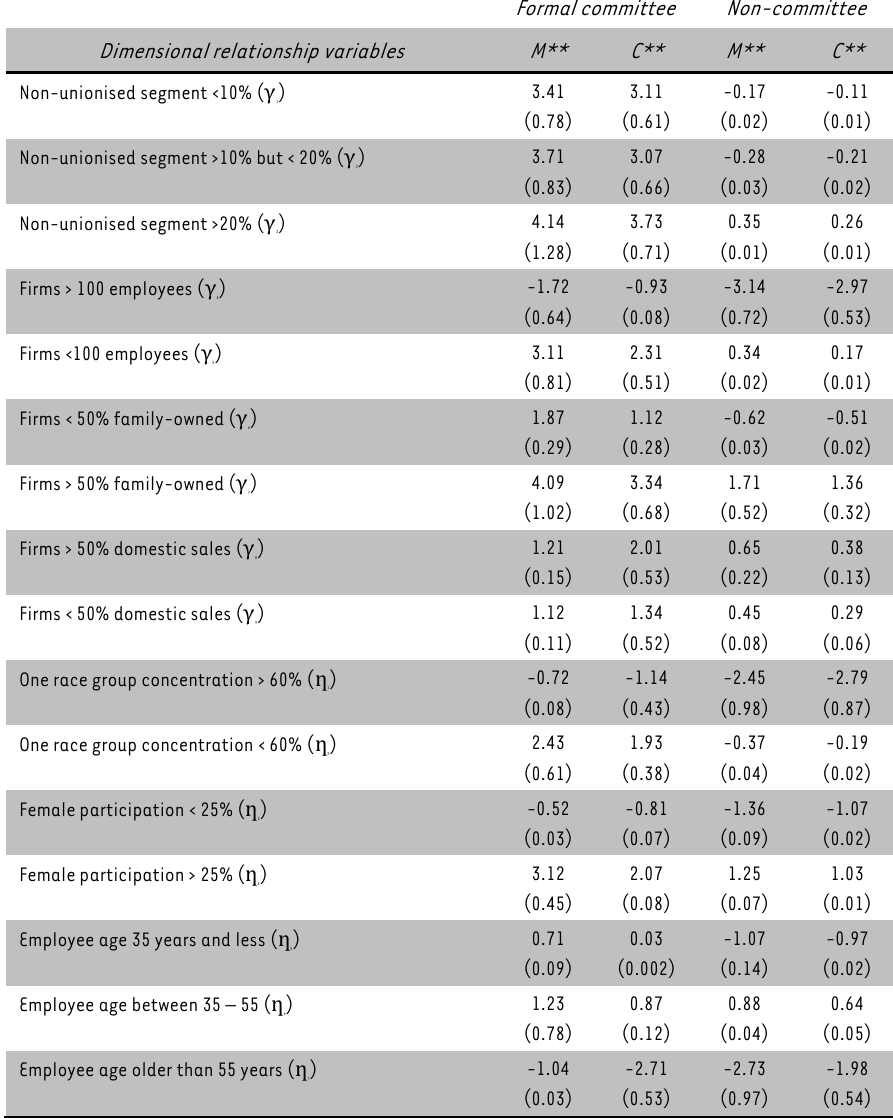
TABLE 1: Fixed-effect panel data employee productivity estimates for the dimensional relationship variables of formal committee and non-committee participation platforms of the lower-skilled non-unionised employee